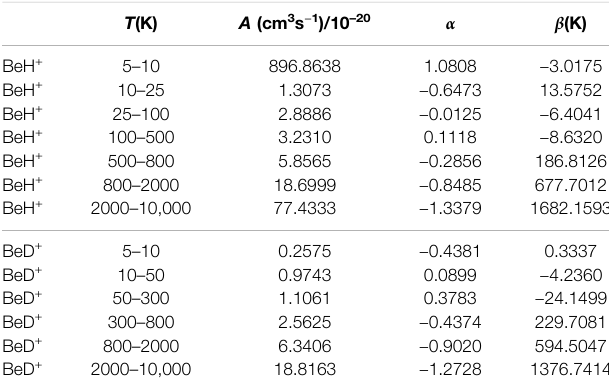
TABLE1| FittingparametersoftheextendedArrheniuscurvesfortheformationof BeH + and BeD + that are obtained from BW rate coef fi